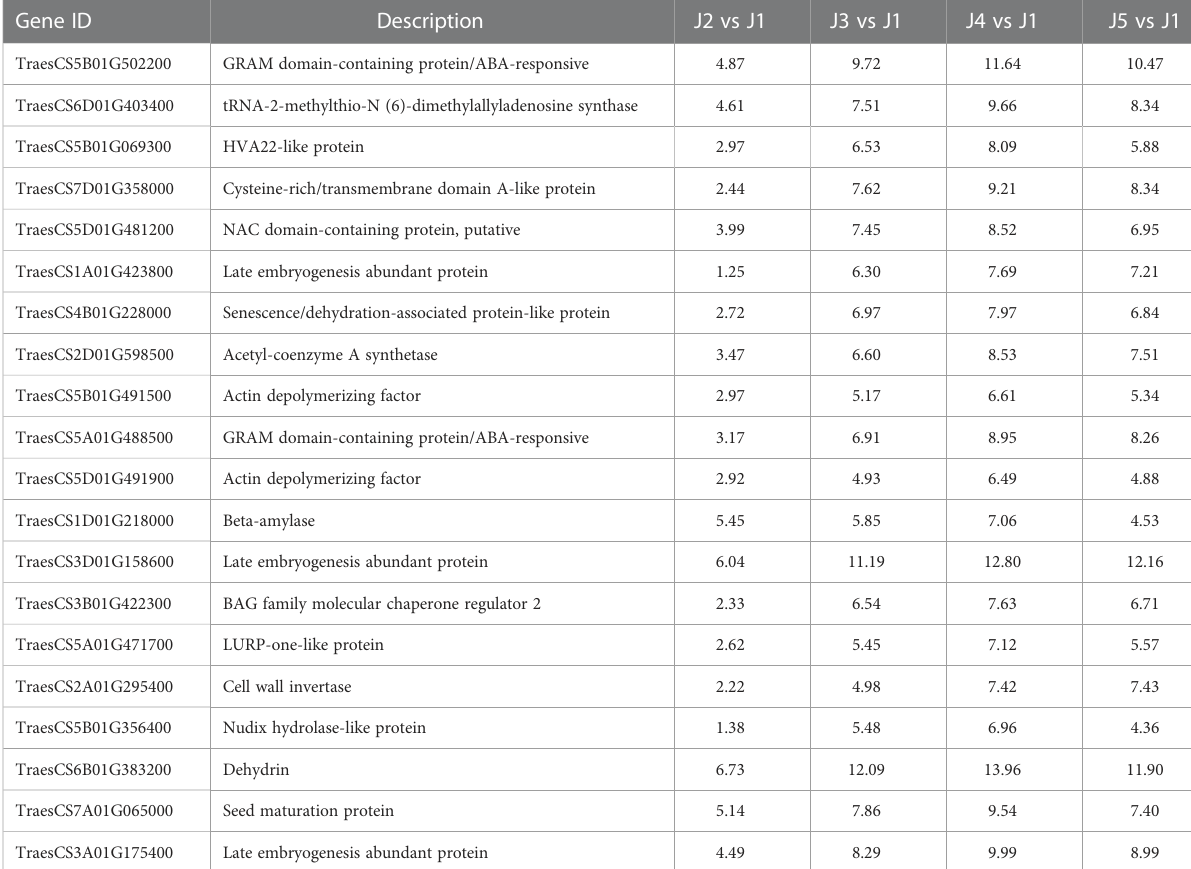
TABLE 3 Representative mostly up-regulated genes shared in all time points, shown as log2 value of fold